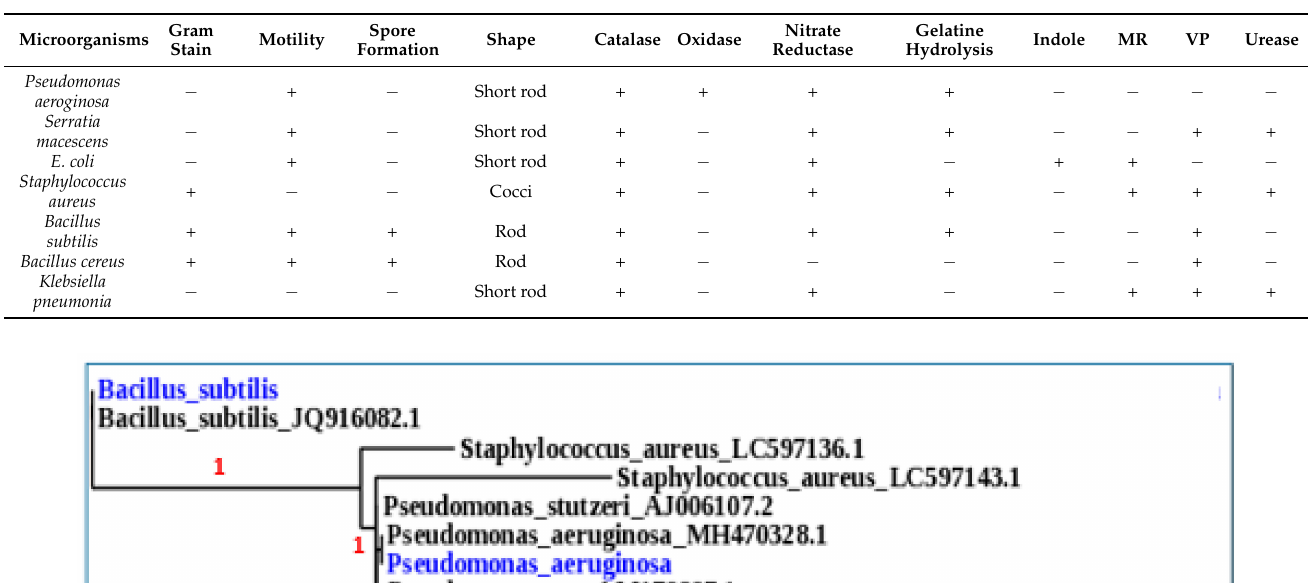
Table 9. Morphological and biochemical tests of six bacterial isolates.